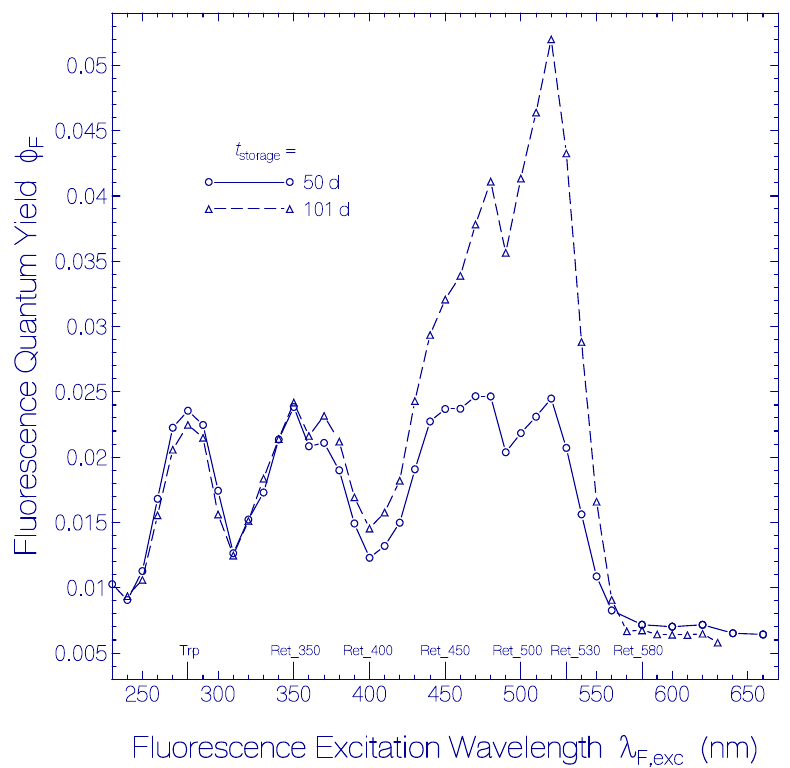
Figure 9. Dependence of the total fluorescence quantum yield φ F on fluorescence excitation wavelength λ F,exc for QuasAr1 in pH 8 Tris buffer stored in the dark at room temperature ( ϑ = 21–25 °C) for durations of 50 days and 101 days.